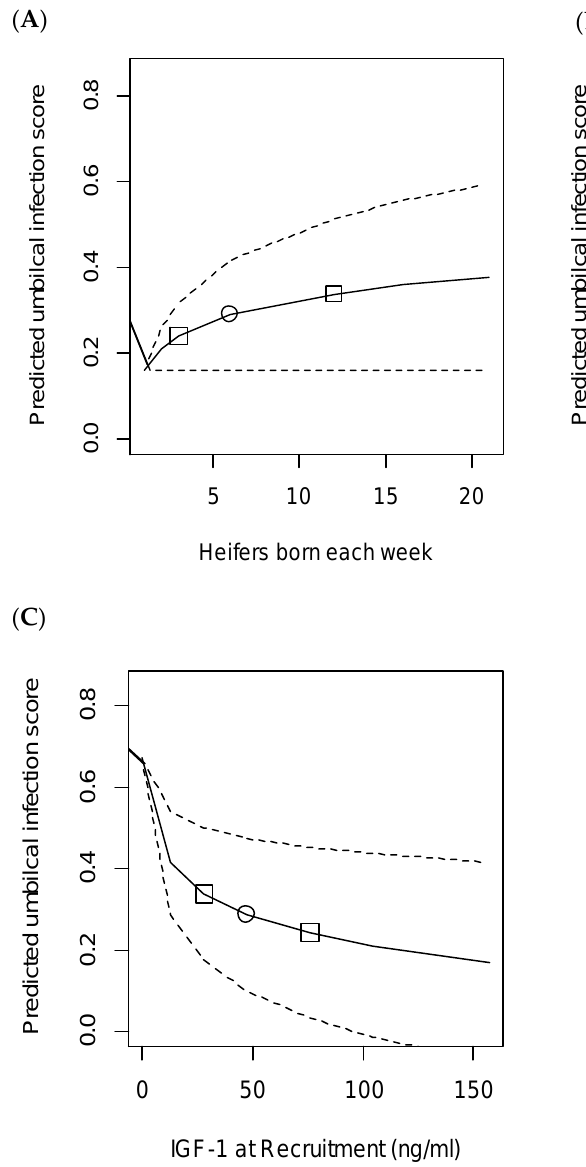
Figure 5. Predicted composite umbilical infection score in the first nine weeks based on variation in ( A ) heifer calving intensity (number of heifers born in the same week on the same farm as each individual); ( B ) mean temperature in the month of birth and ( C ) IGF-1 at recruitment. The predicted score was calculated using the linear mixed model output described in Table 5. The study included 492 heifers recruited from 11 farms. For each figure, median values of all other variables were assumed, which were: calving intensity, six heifers born in the same week; mean temperature, 9.5 ◦ C; IGF-1 at recruitment, 47.1 ng/mL. Effect estimates were then calculated based on varying only the variable of interest from the first to the 99th percentile. Dashed lines show 95% confidence intervals, o median value, □ 25th and 75th centile.